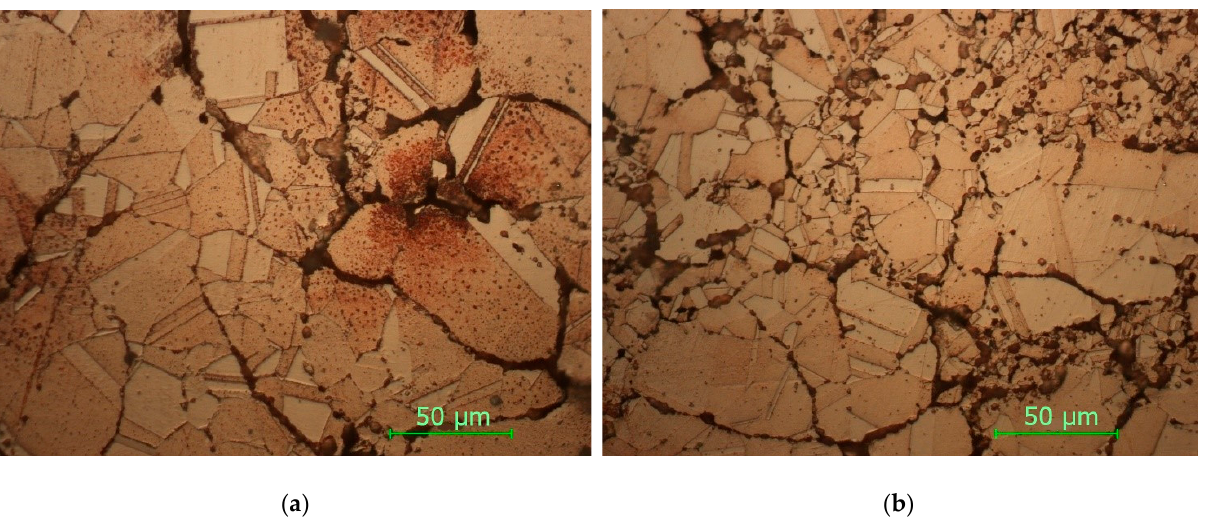
Figure 11. Sample SFW930: ( a ) upper side; ( b ) bottom side (magnification 500 ×